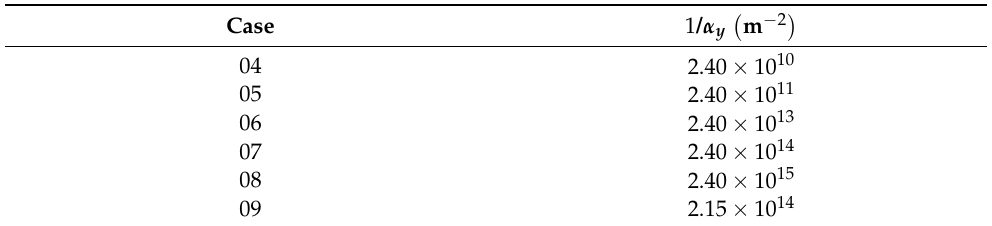
Table 5. Conditions used in hollow fiber membrane